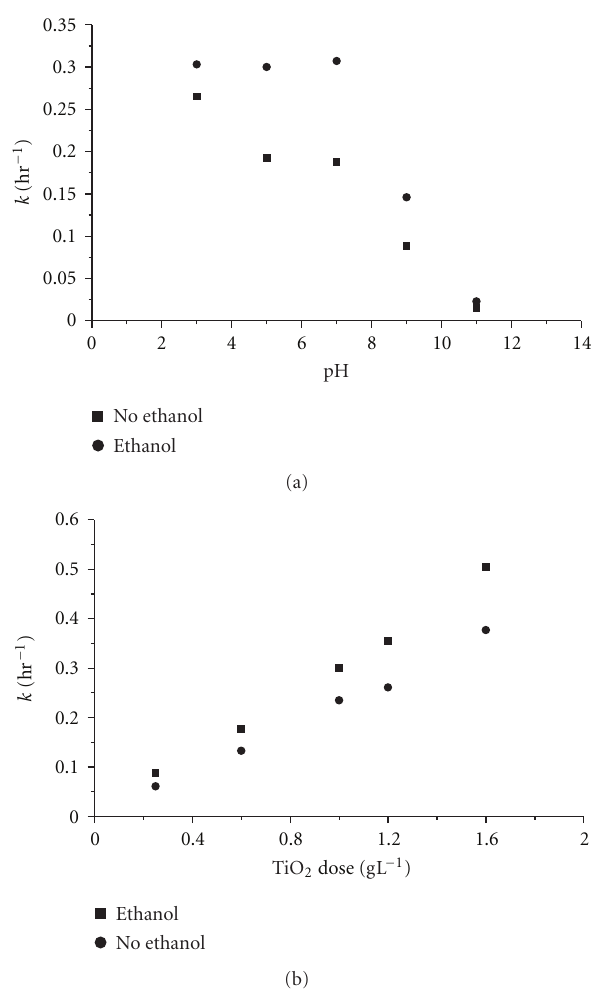
Figure 6: Relationship of the rate constant under di ff erent pH values and di ff erent TiO 2 dose.